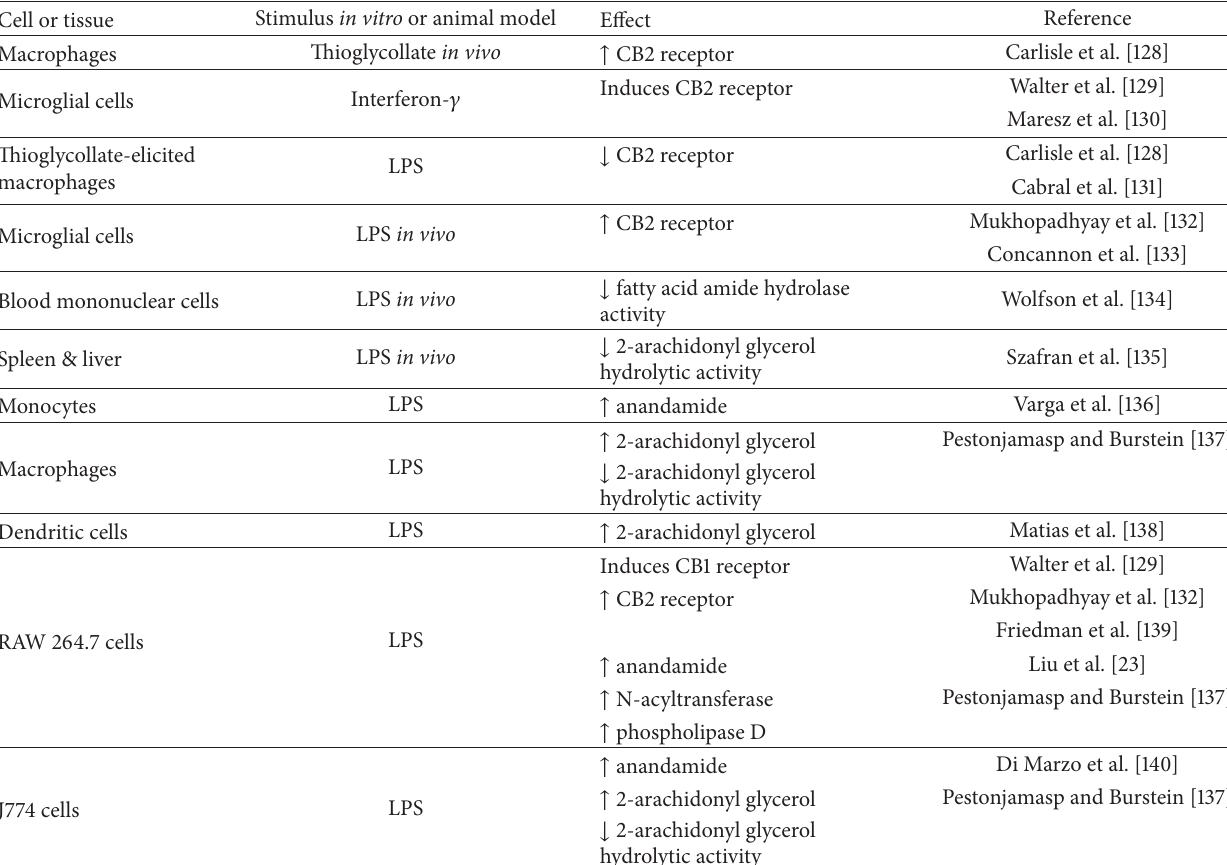
Table 3: Inflammatory effects on endocannabinoid